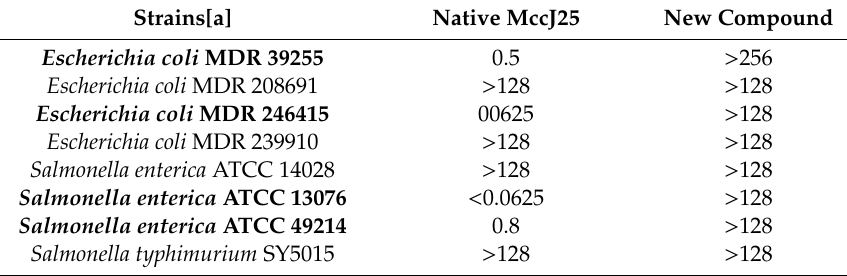
Table 1. Minimum inhibitory concentration (MIC) in µ g / mL of the native MccJ25 and the new compound against eight Gram-negative strains [a]. The sensitive strains to the native MccJ25 are highlighted in